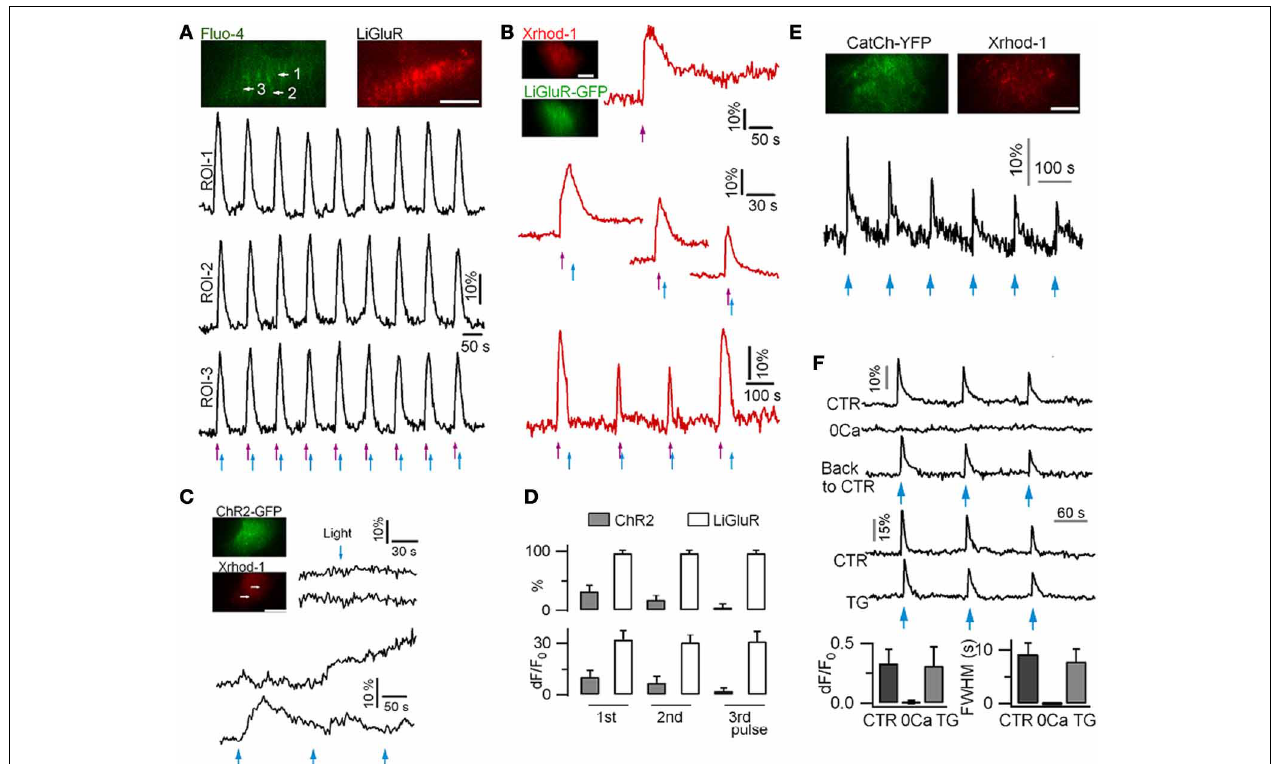
FIGURE 2 | Ca 2 + signals recorded in mouse cortical astrocytes in culture using LiGluR, ChR2(H134R) and CatCh photoactivation. (A) Light-gated Ca 2 + rises in an astrocyte expressing LiGluR-mRFP. Ca 2 + rises were imaged with dual-color TIRFM and repetitively switched on and off by 385-nm (violet arrows, 0.3mW/mm 2 , 50ms) and 488-nm (blue arrows, 39.1mW/mm 2 , 200ms) light pulses, respectively. (B) LiGluR(GFP)-gated astrocytic Ca 2 + elevations monitored with the red-fluorescent Ca 2 + dye Xrhod-1. (C) In astrocytes expressing ChR2(H134R), short photoactivation (458-nm, 27.3mW/mm 2 , 500ms) of ChR2 failed to evoke near-membrane Ca 2 +